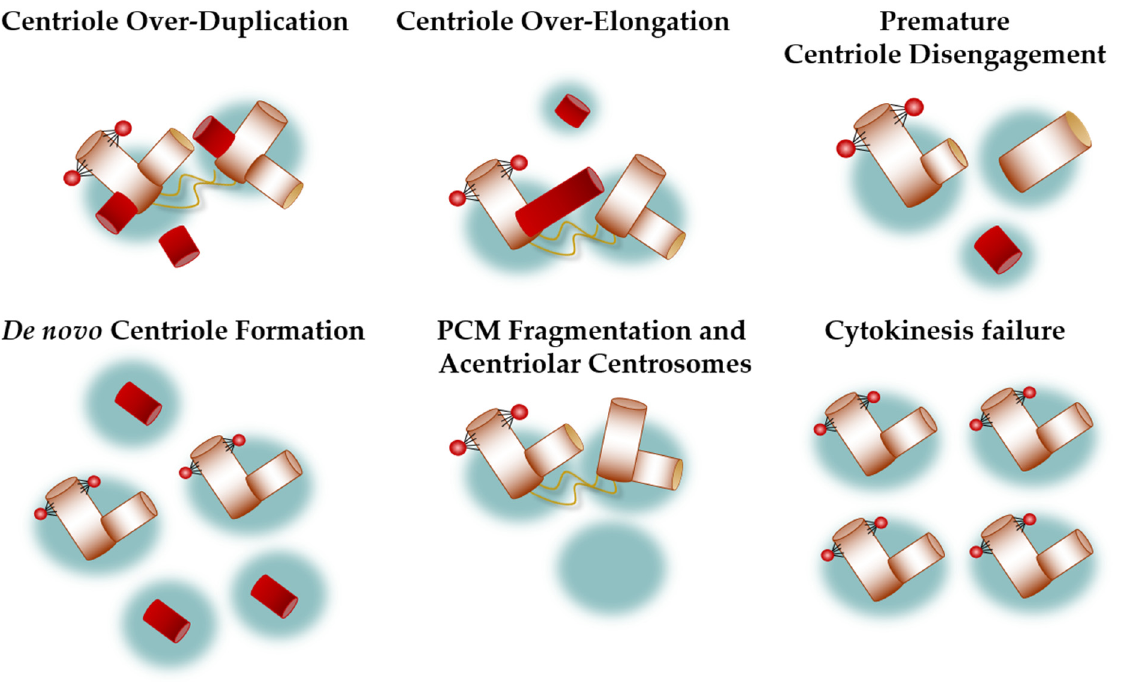
Figure 2. Origin of Centrosome Defects. Centrosome defects include structural and numerical changes. Structural defects include alterations in centriole size, length, or the amount of pericentriolar material, among others. Numerical changes are defined by more than two centrosomes per cell and are referred to as centrosome amplification (CA). Many mechanisms underlie the etiology of centrosomal alterations, these include centriole over-duplication, centriole over-elongation, premature centriole disengagement, de novo centriole formation, PCM fragmentation, and cytokinesis